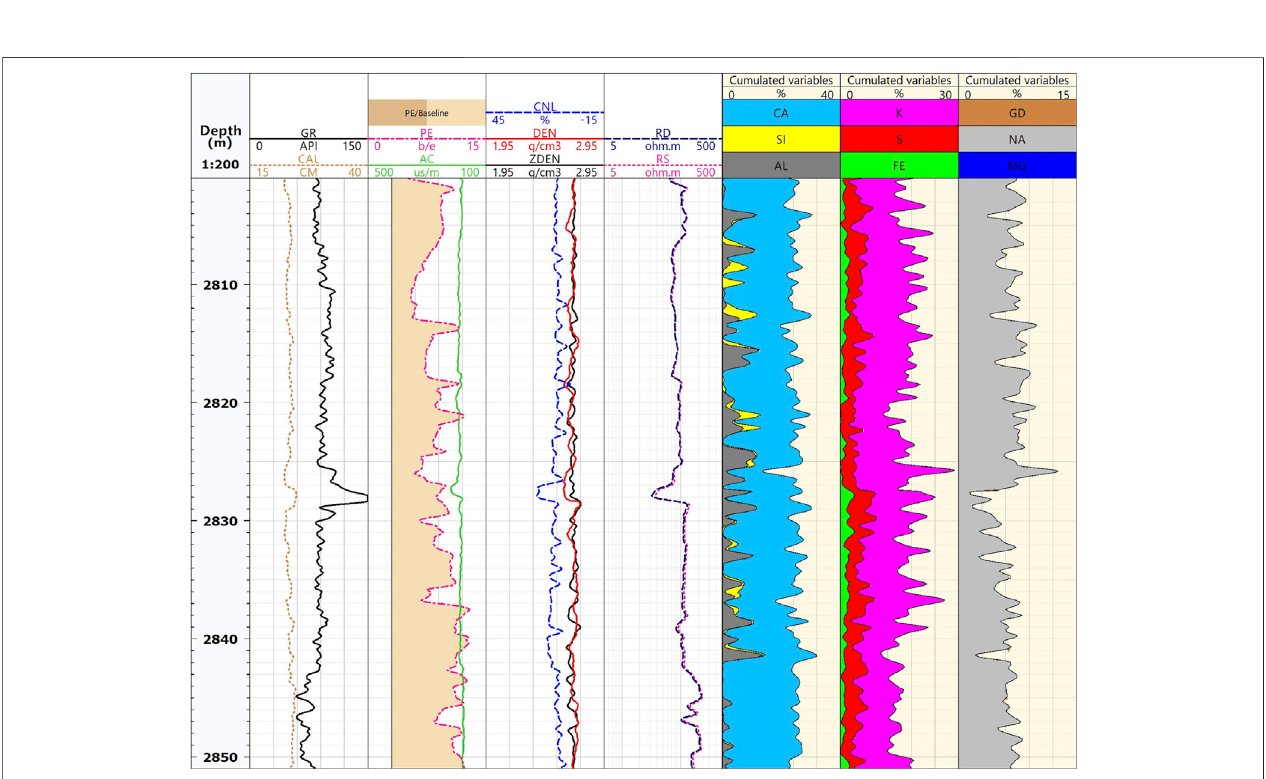
FIGURE 15 | Density comparison in a tight carbonate zone. The neutron-gamma density measurements (track 3, red) and conventional gamma density measurements (black) are highly consistent.